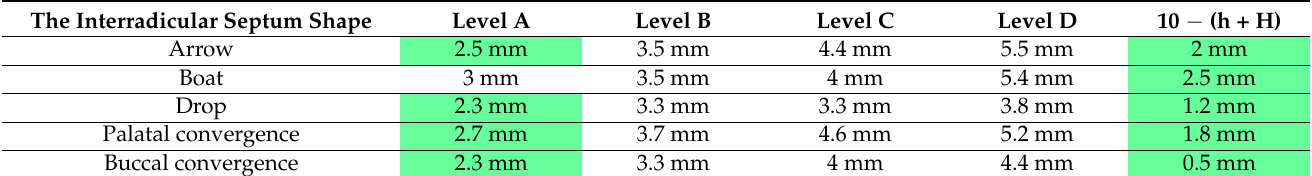
Table 4. The relationship between the average values of the IRS parameters obtained in the coronal view and the minimal recommended IRS diameters for the second maxillary molars according to the IRS shape (critical points are colored). The last column represents the value of vertical diameter required to achieve implant stability (above 10